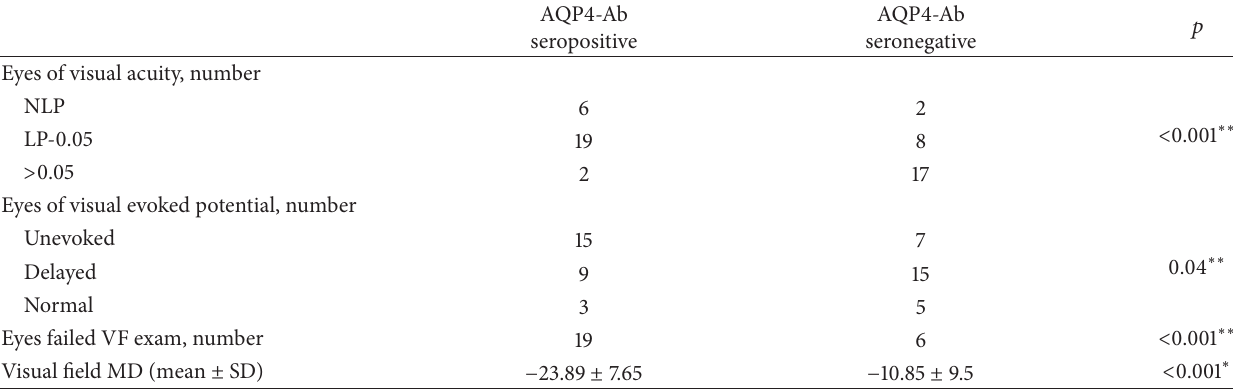
Table 2: Visual function of patients with